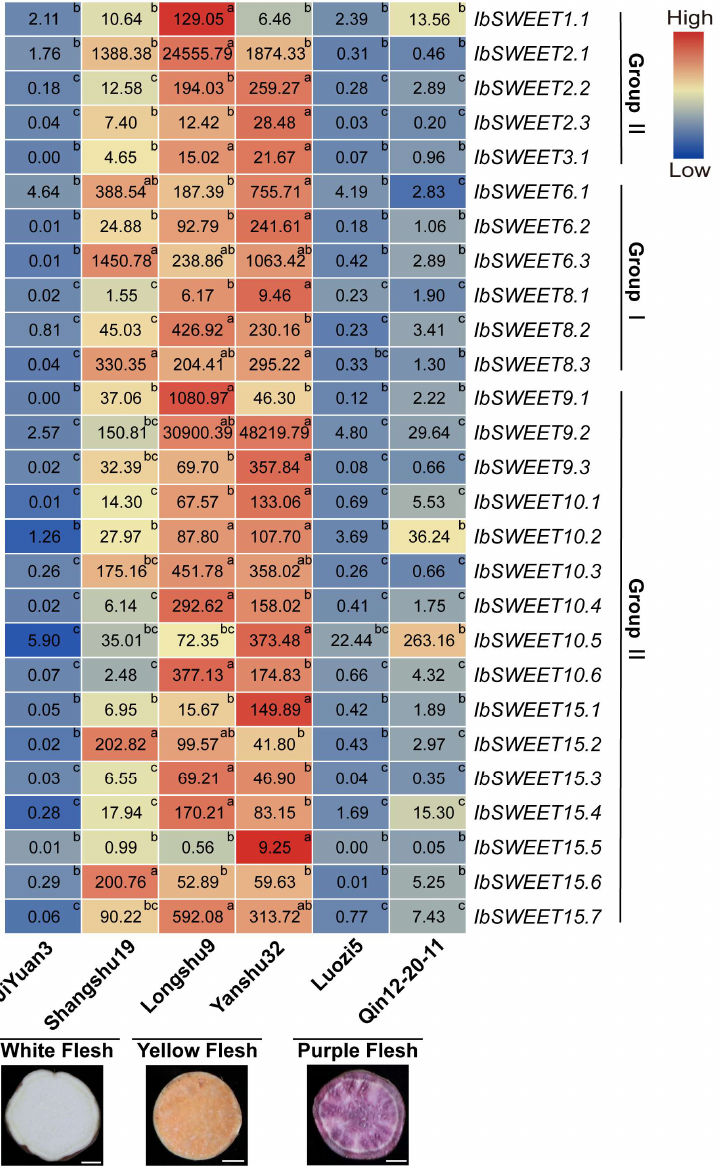
Figure 9. Gene expression patterns of IbSWEETs in different sweet potato varieties with different flesh colors. The values were determined by qRT-PCR from three biological replicates consisting of pools of three plants, and the results were analyzed using the comparative C T method. The expression of IbSWEET6.2 in Qin-12-20-11 was considered as “1”. The fold changes are shown in the boxes. Different lowercase letters indicate a significant difference of each IbSWEET at p < 0.05 based on Student’s t -test. Scale bars, 1 cm.